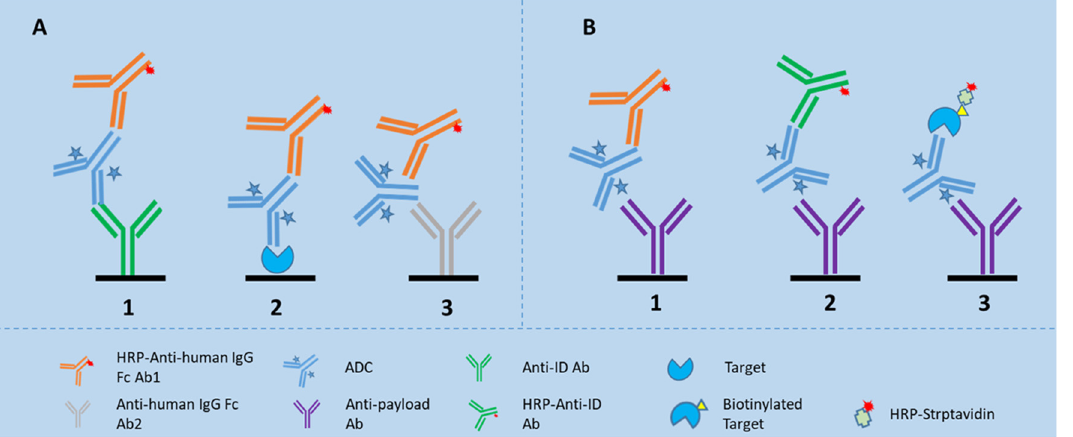
Figure 1. LBA assay formats for detection of TAb and ADC in the biomatrices. ( A ) shows the assay formats for TAb, of which Assay 1 is configured with an anti-idiotypic antibody for capture and an anti-Fc antibody for detection; Assay 2 is configured with the drug target for capture and an anti-Fc antibody for detection; and Assay 3 is a generic assay configured with one anti-Fc antibody for capture and another anti-Fc antibody for detection; ( B ) shows the assay formats for ADC, of which Assay 1 is configured with an anti-toxin antibody for capture and an anti-Fc antibody for detection; Assay 2 configured with an anti-toxin antibody for capture and an anti-idiotypic antibody for detection; and Assay 3 is configured with an anti-toxin antibody for capture and biotinylated drug target together with HRP-labeled streptavidin for